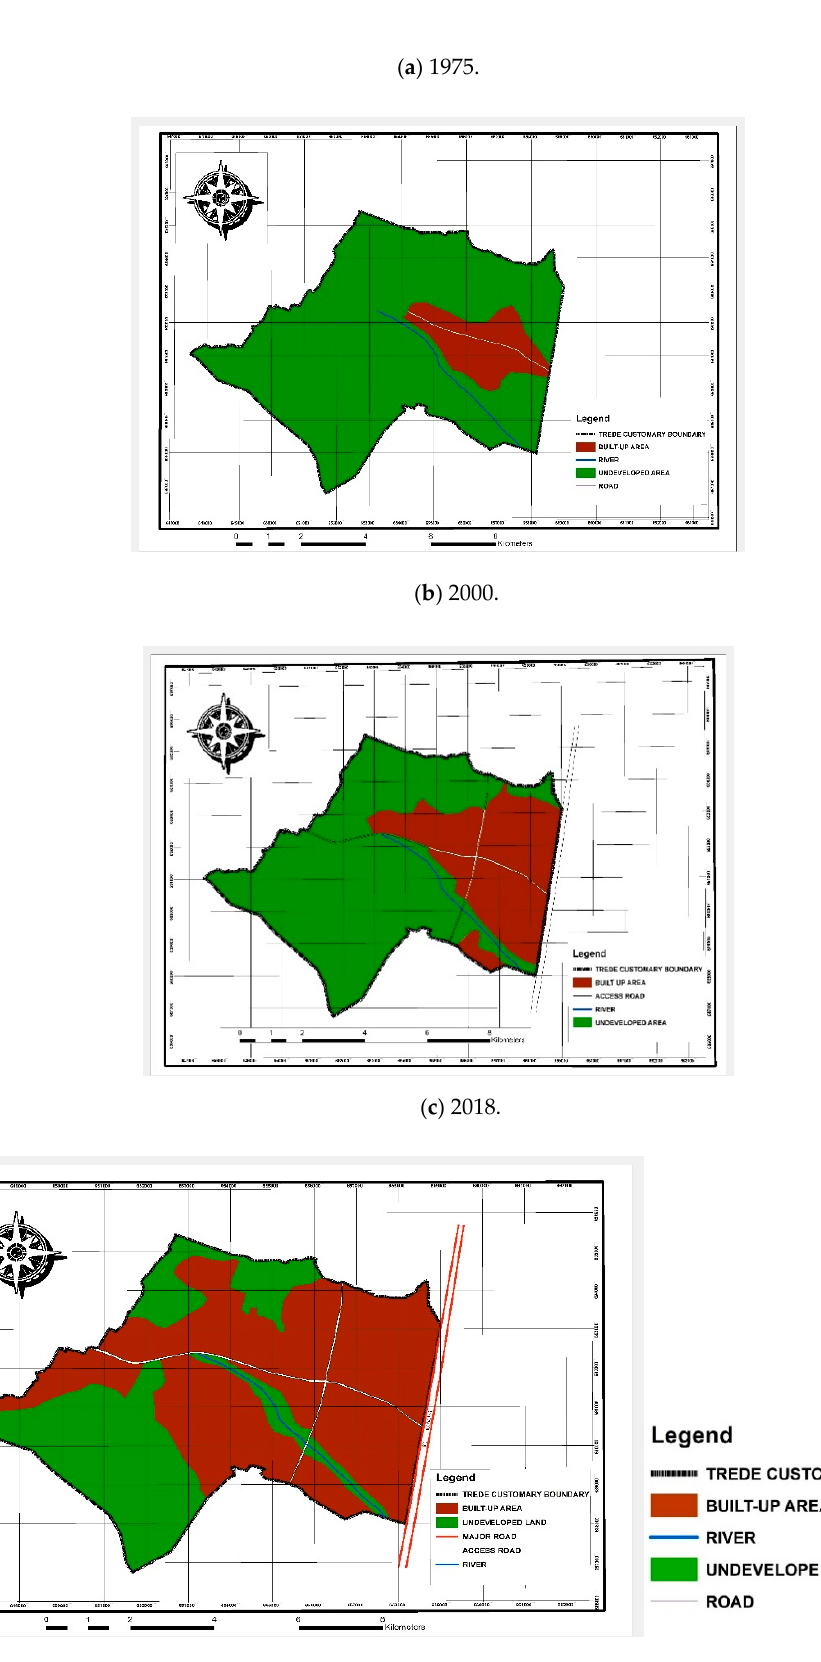
Figure 3. Maps of built-up area of Trede between 1975–2018, ( a ) 1975, ( b ) 2000, and ( c ) 2018 (source: Authors (based on Geographic Information System Analysis).